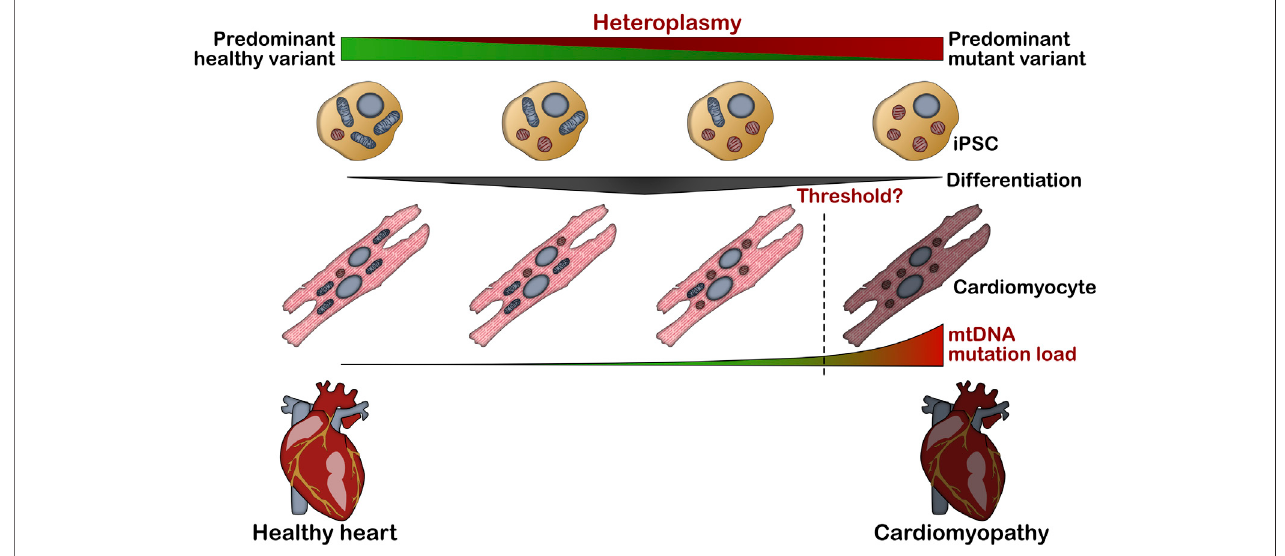
FIGURE 2 | Impact of mtDNA heteroplasmy levels on cardiomyocyte pathology. mtDNA heteroplasmy associated to pathogenic variant load in iPSCs is typically preserved during cardiomyocyte differentiation, promoting poor mitochondrial performance and cardiac remodeling when mtDNA variant load exceeds a certain.